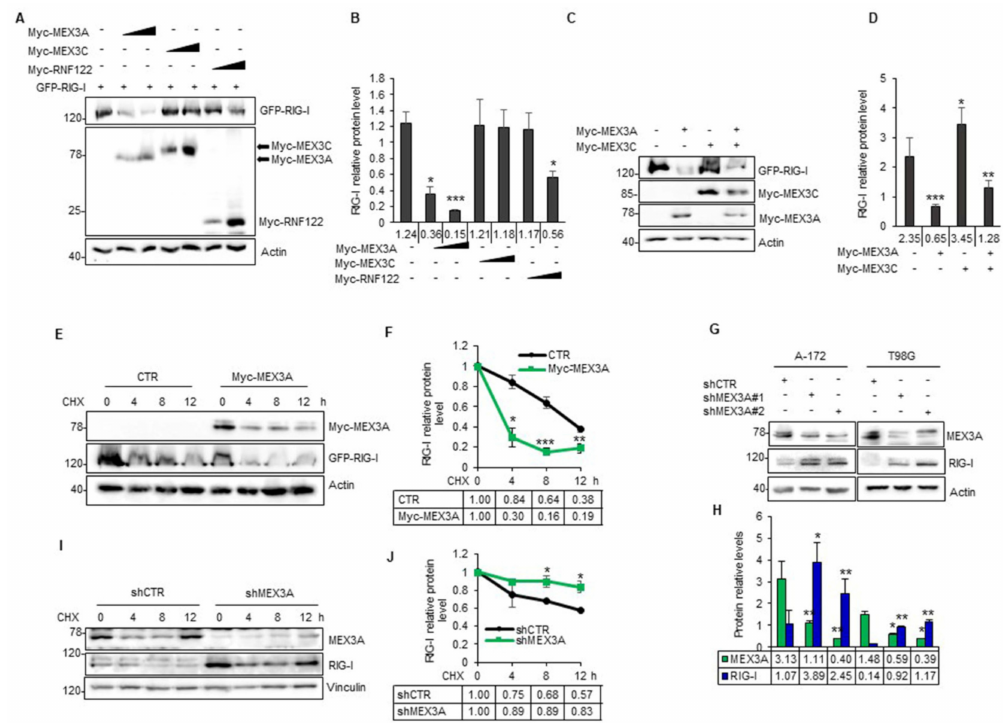
Figure 4. MEX3A expression a ff ects RIG-I protein stability. ( A , B ) Representative immunoblotting ( A ) and densitometric analysis ( B ) of GFP-RIG-I protein level in HEK293T cells transfected with increasing amounts of Myc-tagged MEX3A, MEX3C and RNF122, in a (1:1) and (1:0.5) ratio, compared to the amount of the transfected GFP-RIG-I. ( C ) HEK293T cells were transfected with equal quantities of GFP-RIG-I and Myc-tagged MEX3A and MEX3C, alone or in combination. The levels of the indicated protein were assessed by immunoblot analysis. ( D ) Densitometric analysis of GFP-RIG-I protein levels shown in ( C ) and normalized on actin levels. ( E ) HEK293T cells were co-transfected with GFP-RIG-I, an empty vector as control or Myc-MEX3A, in a ratio (1:0.5). Twelve hours after transfection, GFP-RIG-I half-life was assayed, following treatment with CHX (100 µ g / mL), at the indicated time. ( F ) Densitometric analysis of RIG-I protein levels shown in ( E ) and normalized on actin levels. ( G ) Protein expression levels of endogenous MEX3A and RIG-I in A-172 and T98G GB cell lines transduced with lentiviral vectors encoding either control shRNA (shCTR) or MEX3A shRNAs